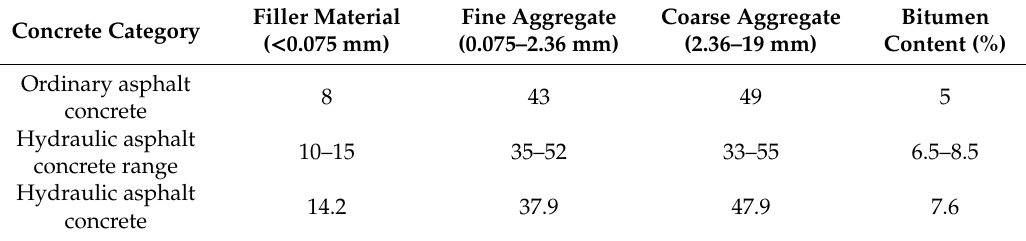
Table 1. Mix ratio of asphalt concrete (% by weight of total